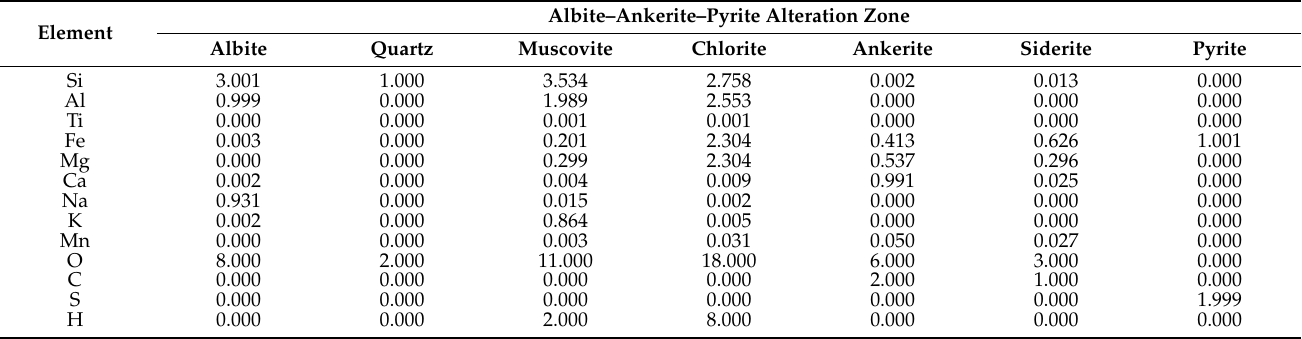
Table 5. Mineral formulae calculated from electron microprobe analysis used for the balanced mineral reactions of albite–ankerite–pyrite alteration